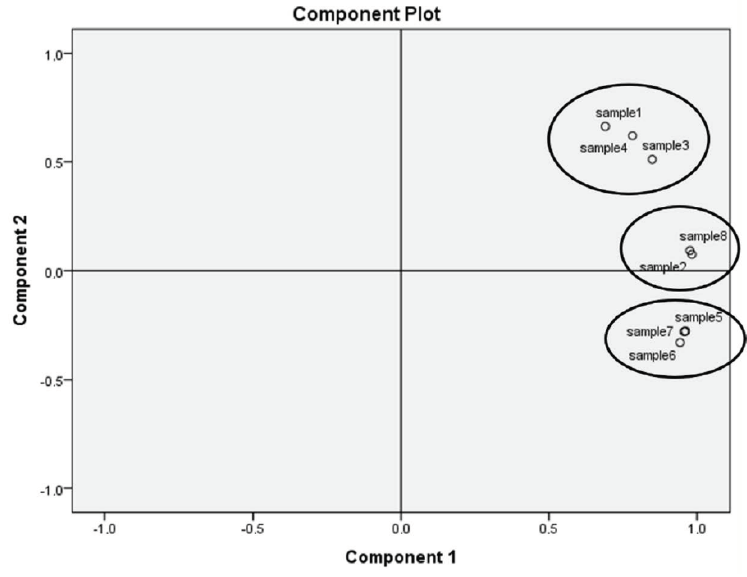
Figure 1. Principal Components Analysis (PCA) of medlar jam – all determined parameters. Explan-